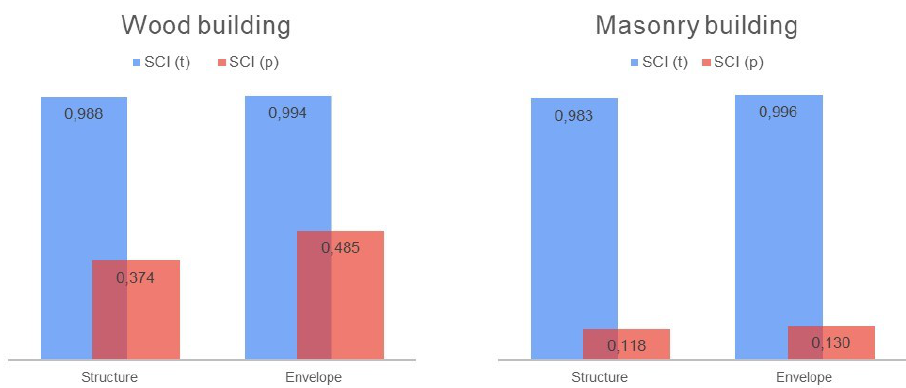
Figure 5. Mass distribution [t] for values the cases